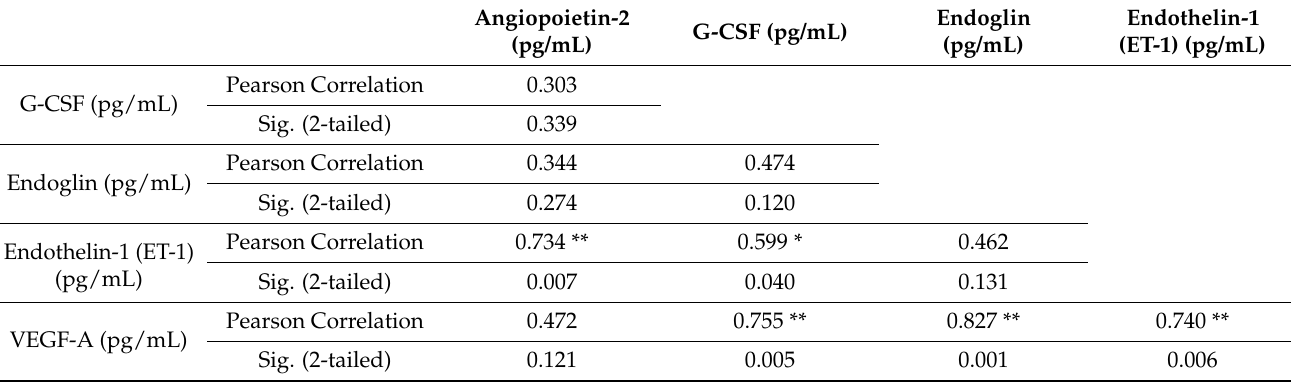
Table 2. Pearson correlations between angiogenesis markers among the two groups of the study (sham control group and MCAO group).